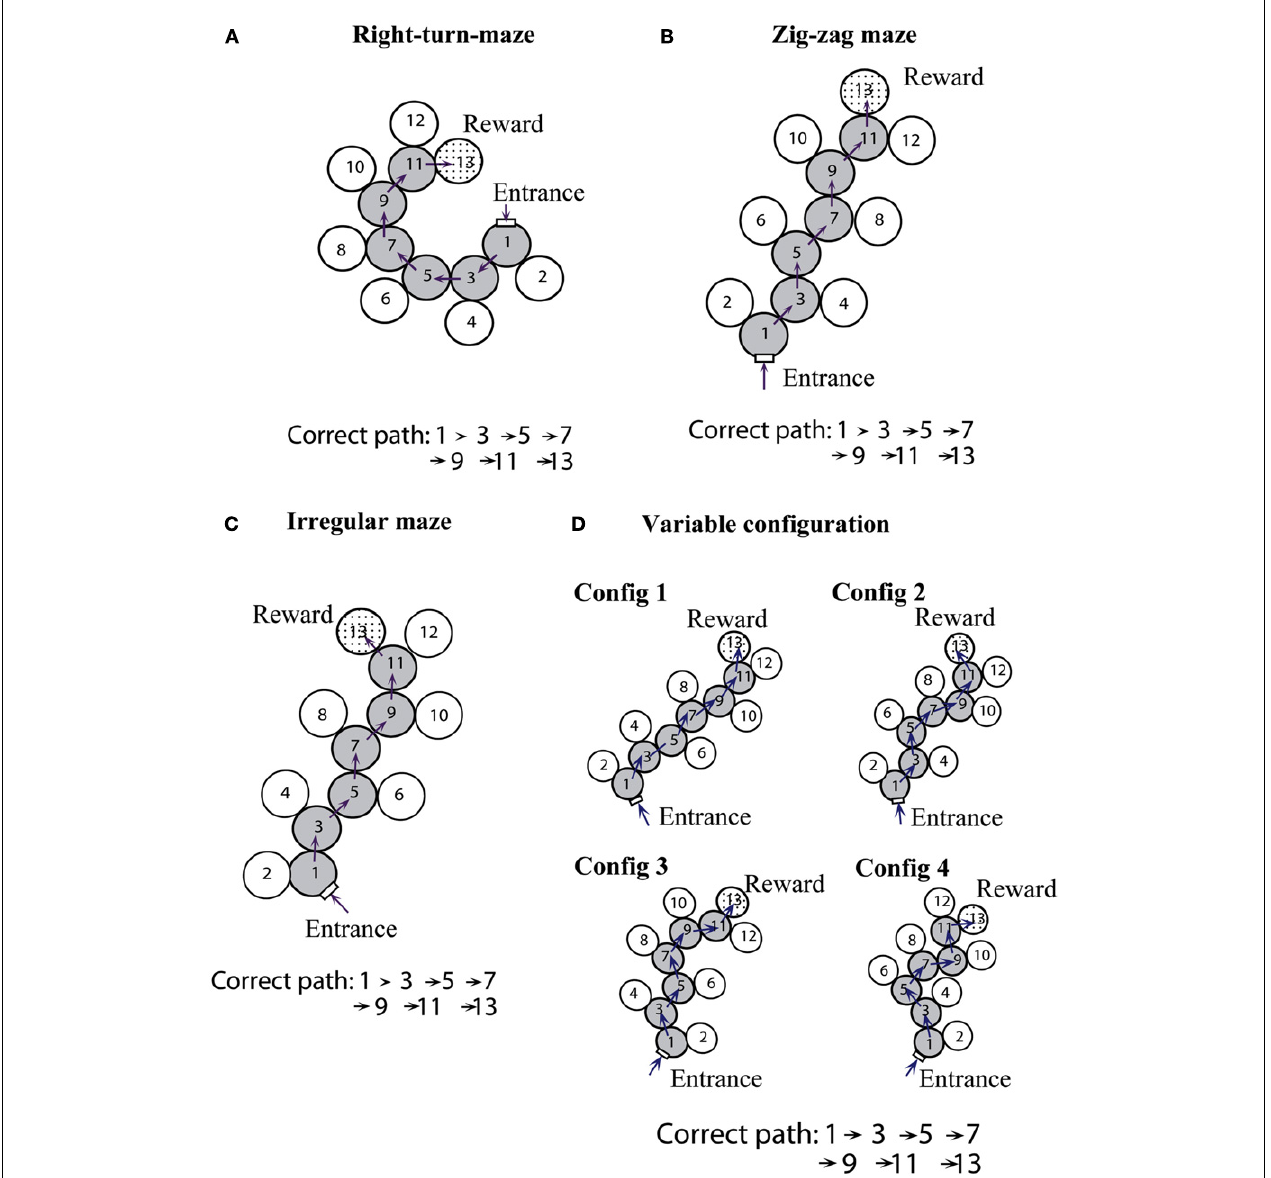
sequence of turns. (D) Variable irregular mazes: four configurations have to be learned simultaneously. Modified from Zhang et al. (2000). Details in